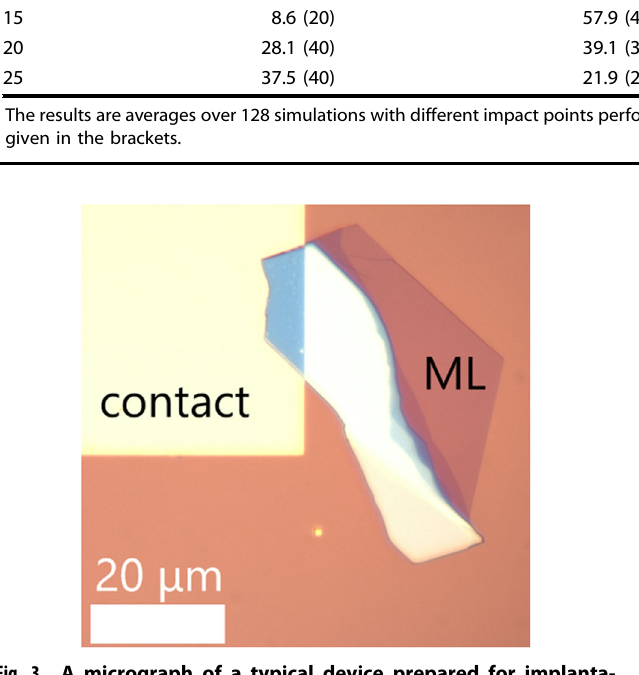
Fig. 3 A micrograph of a typical device prepared for implanta- tion. The exfoliated MoS 2 fl ake containing a ML is placed on a Si/ SiO 2 substrate with metal contact pads. The thicker part of the MoS 2 fl ake makes contact with the Ti/Au contact pad. A fi lter was applied on the optics for better contrast on the ML.